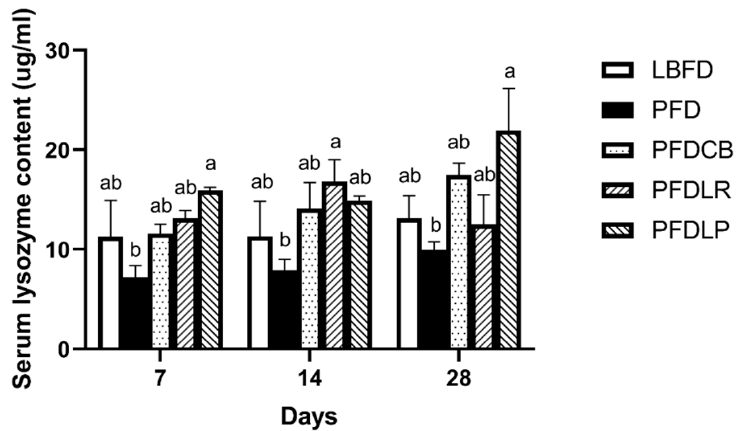
Figure 3. Serum lysozyme content of mandarin fish in different feeding groups (LBFD, PFD, PFDCB, PFDLR and PFDLP) at day 7, 14 and 28 of feeding. Data are presented as mean ± SEM ( n = 9).